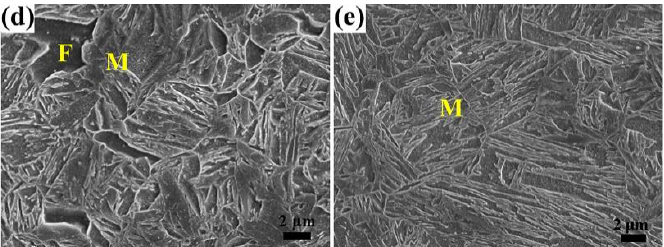
Figure 1. SEM microstructure of high-strength low-alloy (HSLA) steel quenched from ( a ) 790 ◦ C, ( b ) 810 ◦ C, ( c ) 830 ◦ C, ( d ) 850 ◦ C, and ( e ) 900 ◦ C, and tempered at 180 ◦ C. (F = ferrite and M = martensite). Table 2. The volume fraction of ferrite quenched from different temperatures.